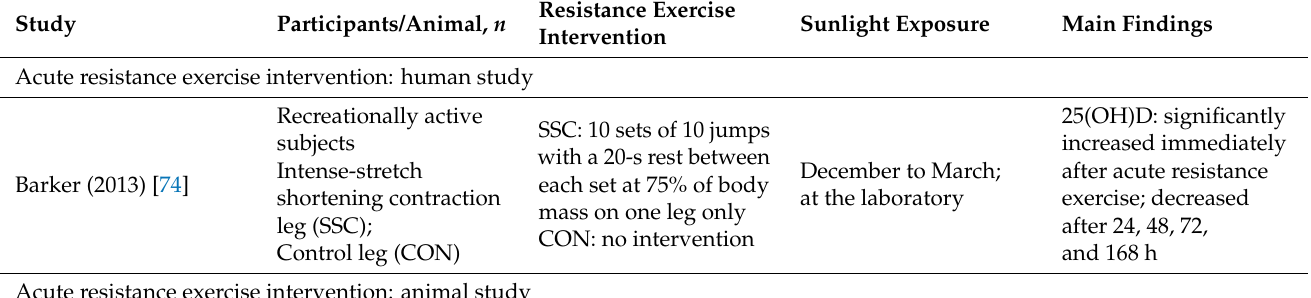
Table 2. Summary of the effect of resistance exercise intervention (human study and animal